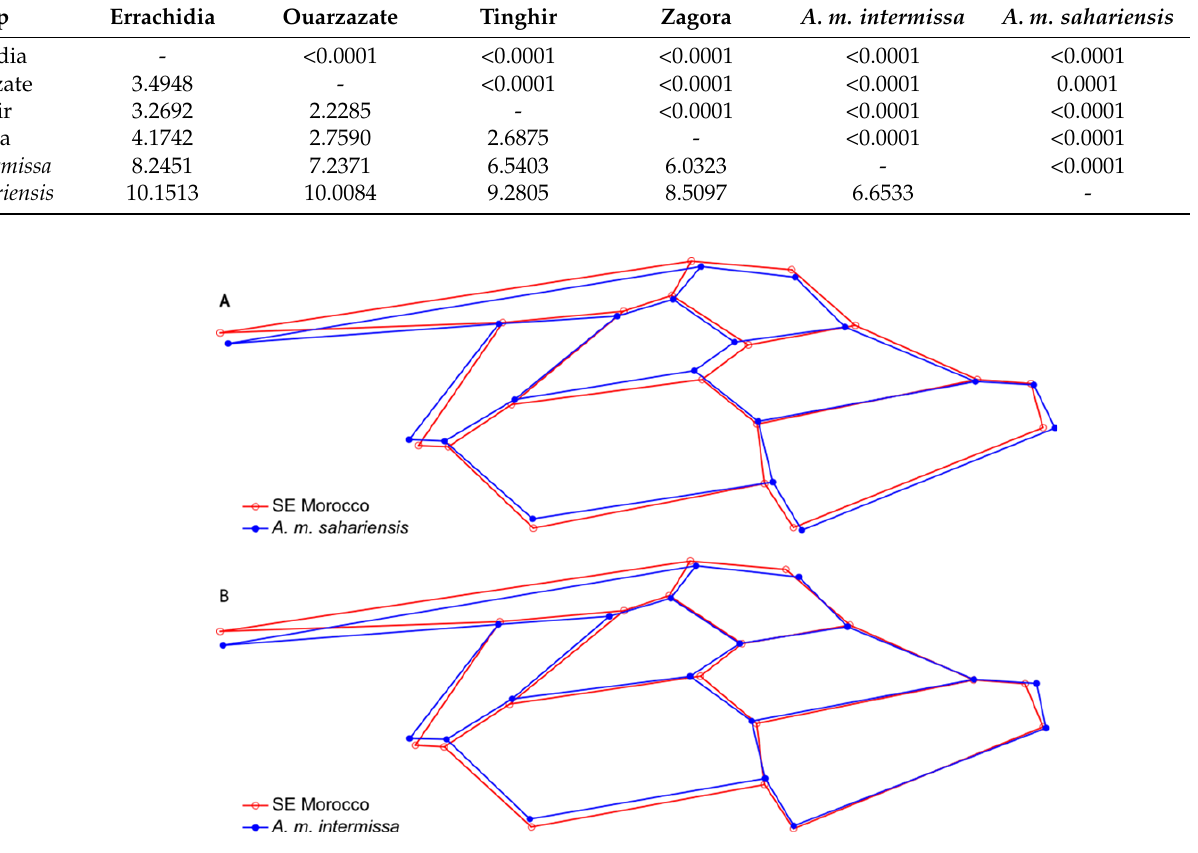
Figure 3. Differences between wing shape of honey bees from south-eastern Morocco and reference samples of A. m. sahariensis ( A ) and A. m. intermissa ( B ) illustrated with wireframe diagrams. The differences were increased by 3-fold for better